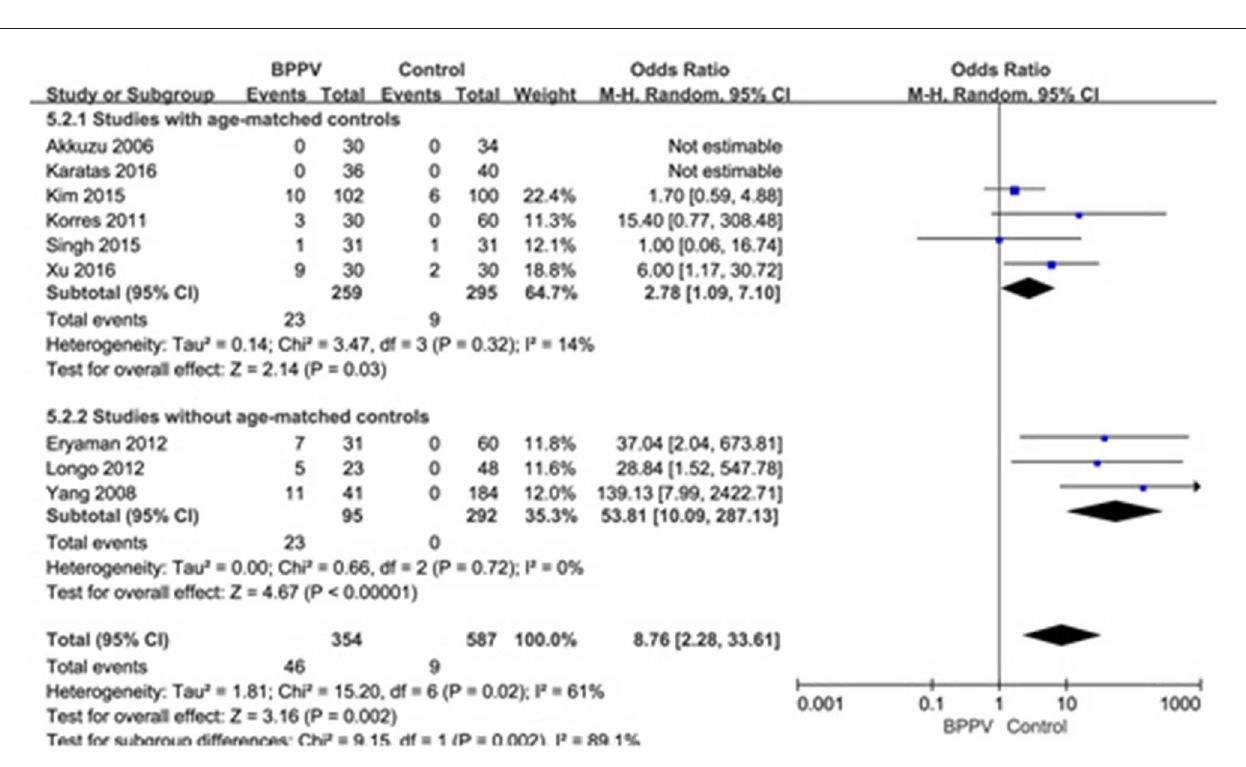
CI = 4.29–16.80, p < 0.00001, Figure 7 ) (20, 25, 26).